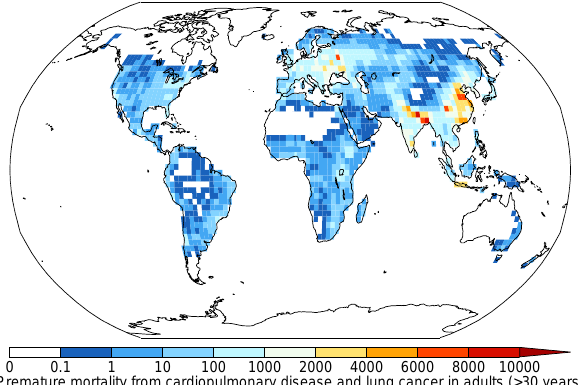
Figure 9. Simulated annual premature mortality (cardiopulmonary diseases and lung cancer) due to ambient exposure to ambient PM 2 . 5 from residential emissions (res_base – res_off).